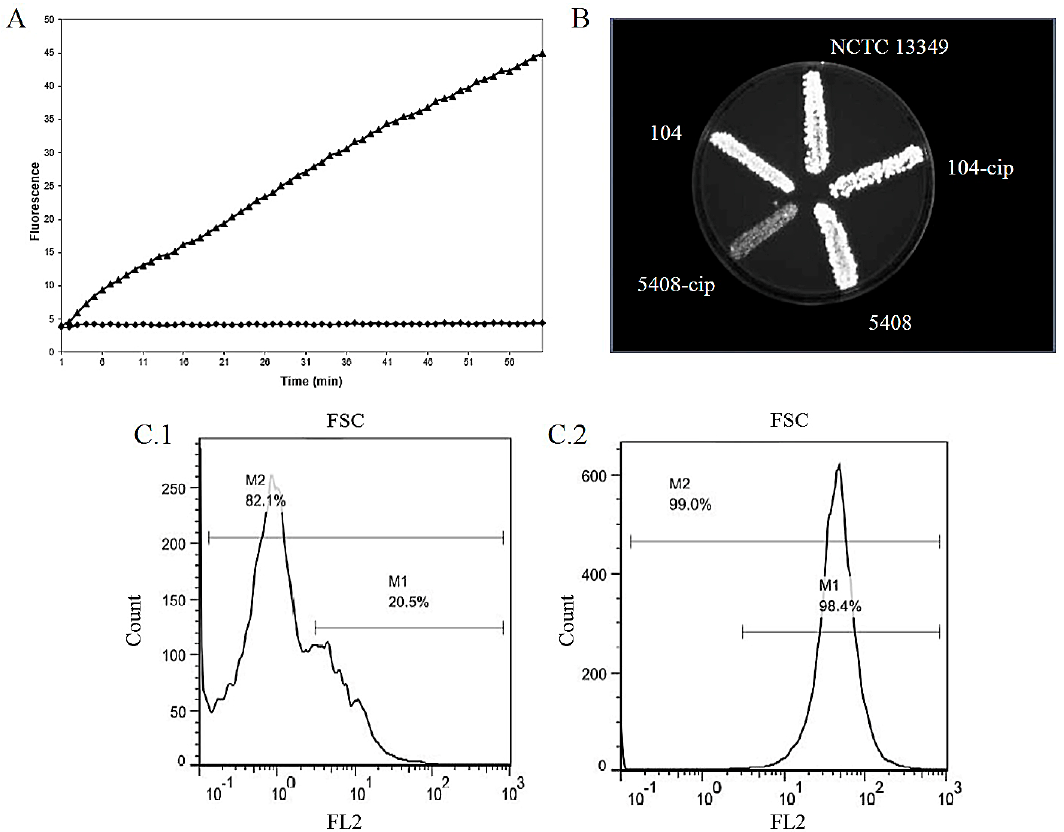
Figure 2. Accumulation methods to measure the activity of bacterial efflux pumps. ( A ) Accumulation of EB by Salmonella enterica serovar Enteritidis 104 at pH 5 in the presence of thioridazine (50 µg/mL) using real-time EB method. The flat curve represents the accumulation of the untreated strain [226]; ( B ) Cartwheel method to monitor efflux activity of control (NCTC 13349), clinical (104, 5408), and ciprofloxacin resistant (104-cip, 5408-cip) Salmonella enterica serovar Enteritidis strains using EB containing (2.5 mg/L) tryptic soy agar plate [177]; ( C.1 ) Accumulation of EB (1 µg/mL) by E. coli AG 100 strain using flow cytometry [158]; ( C.2 ) Accumulation of EB (1 µg/mL) by E. coli AG 100 strain in the presence of thioridazine (20 µg/mL) using flow cytometry [169].